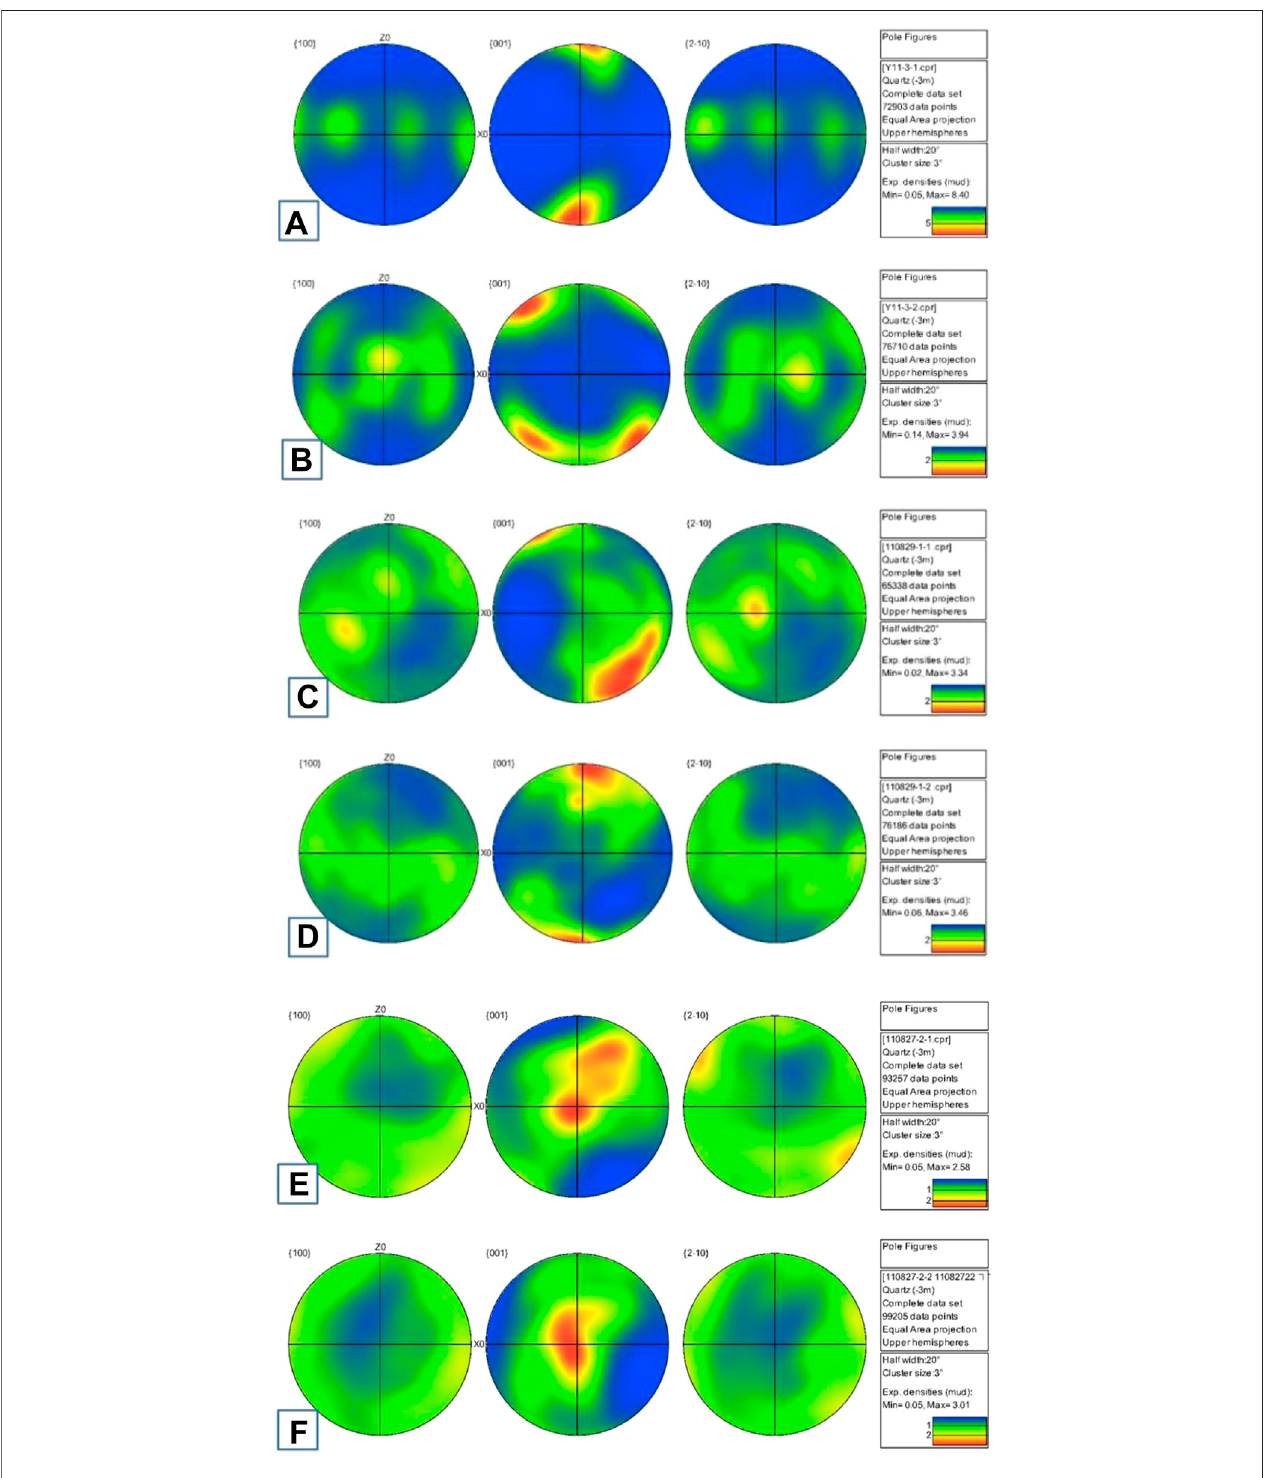
FIGURE 4 | Quartz fabric from EBSD in samples of mylonites. (A) Thin section of Y11-3-1, (B) thin section of Y11-3-2, (C) thin section of 110829-1-1, (D) thin section of 110829-1-2, (E) thin section of 110827-2-1, and (F) thin section of 110827-2-2 (All sections were cut perpendicular to the XY plane of the mylonites, and different numbers − 1 or − 2 in the same sample were parallel or perpendicular to X -axis).